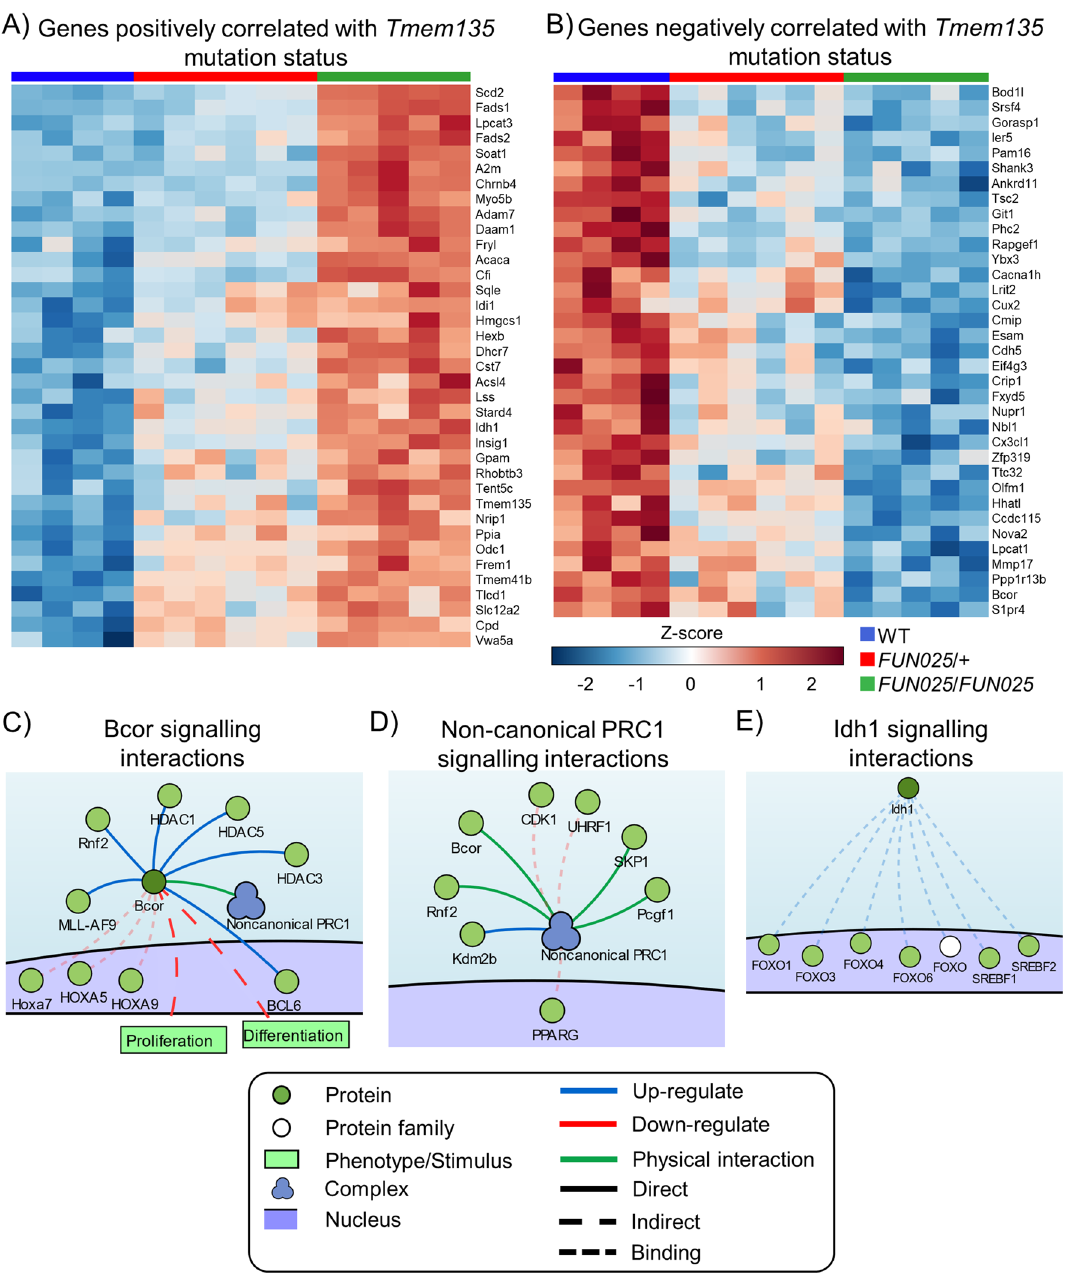
Figure 4. Correlation analysis highlights important signalling pathways affected by Tmem135 mutations. Heatmap of genes which are significantly ( A ) positively and ( B ) negatively correlated (FDR < 0.01) with the number of mutant Tmem135 alleles in 2.5-month-old WT, Tmem135 FUN025 / + , and Tmem135 FUN025/FUN025 eyecups. Signalling network highlights interactions of ( C ) BCL6 corepressor ( Bcor ), ( D ) non-canonical polycomb recessive complex 1 (PRC1), and ( E ) isocitrate dehydrogenase 1 ( Idh1 ). Network generated using the SIGnalling Network Open Resource (SIGNOR